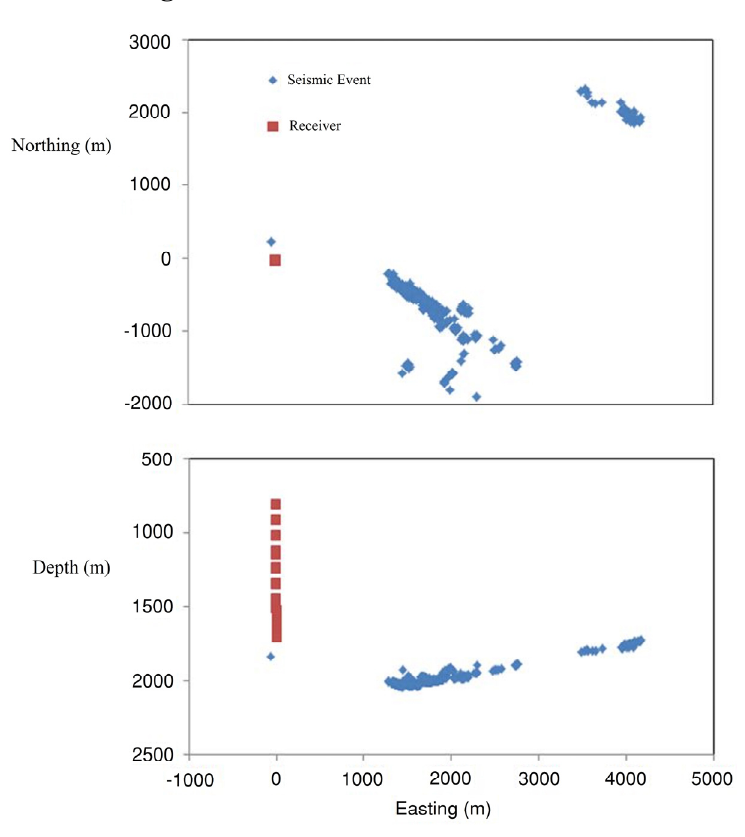
Figure 4. Event and receiver